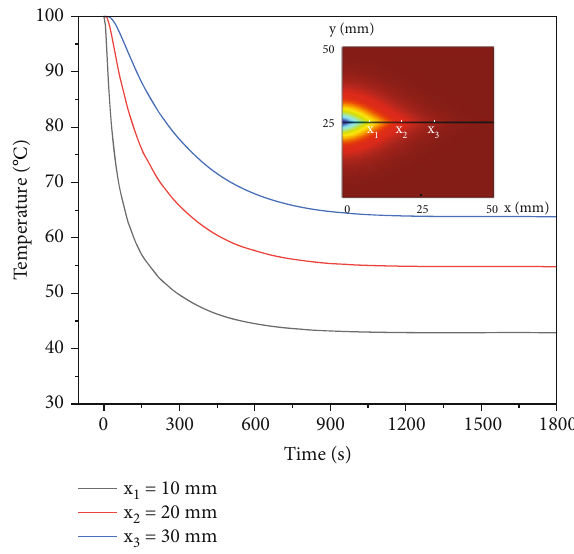
Figure 5: Temperature evolution at di ff erent observation positions along the fracture